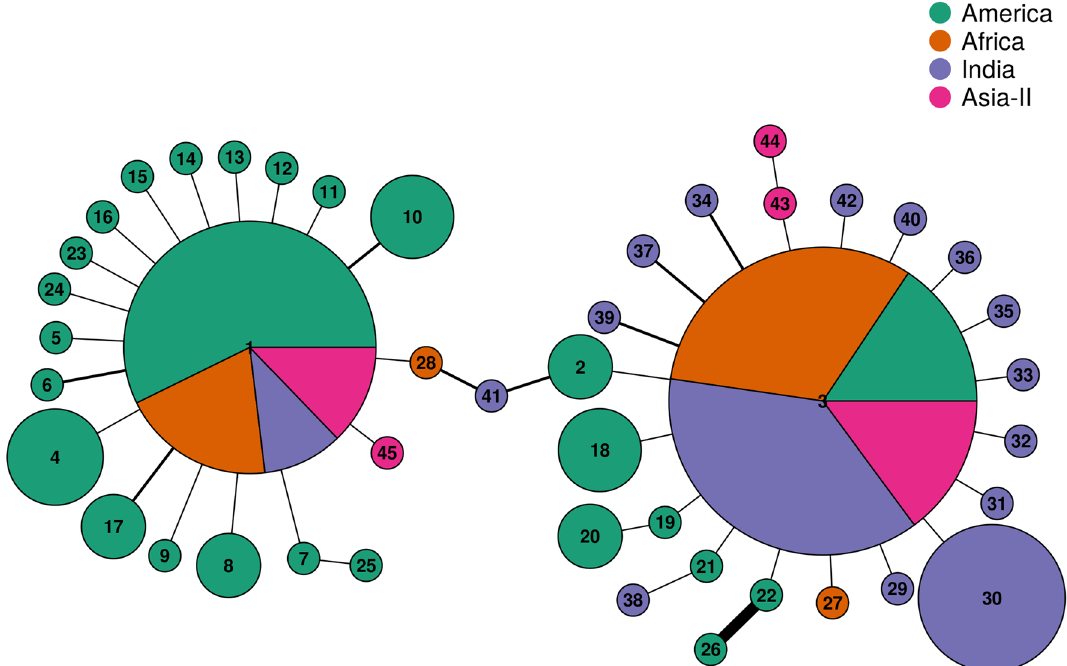
Figure 5. Haplotype network of partial mtCOIA gene sequences of FAW from four geographical groups viz., America, Africa, India and Asia-II. Each pie represents a unique haplotype, the radius of the pie is proportional to the number of sequences belonging to a particular haplotype. The divisions in the pie chart represent the haplotype representation among the four geographical groups. The edge width in the network represent the number of mutation separating the haplotypes from one another, the thinnest edge denotes a single mutation difference.